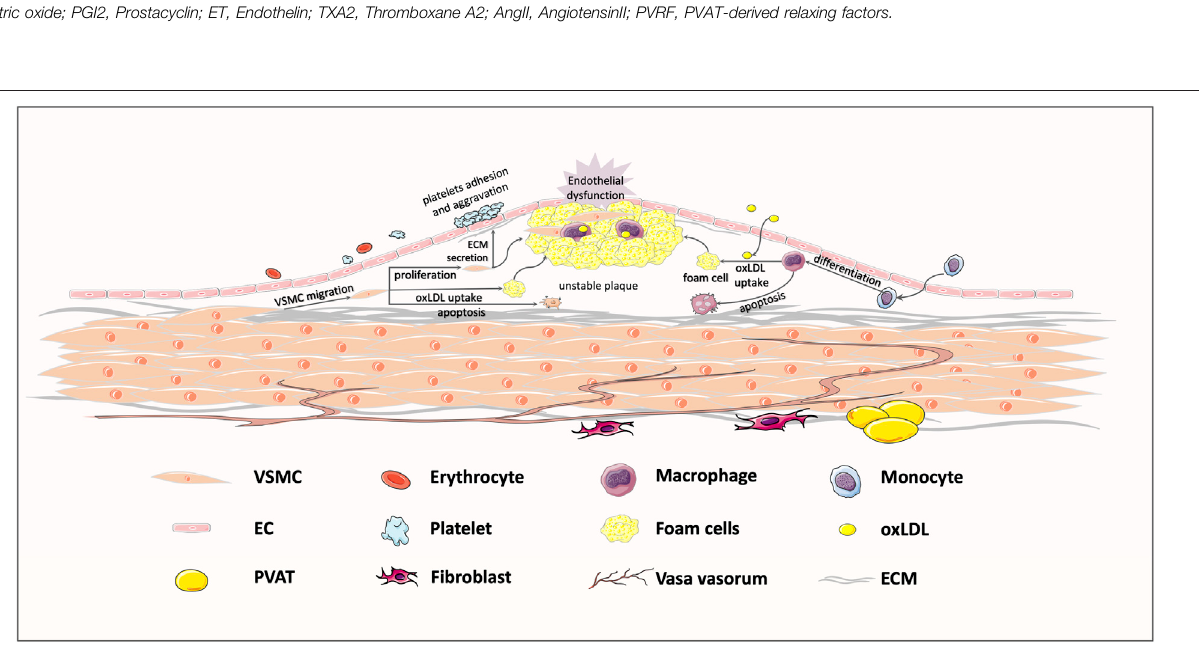
Frontiers in Pharmacology |